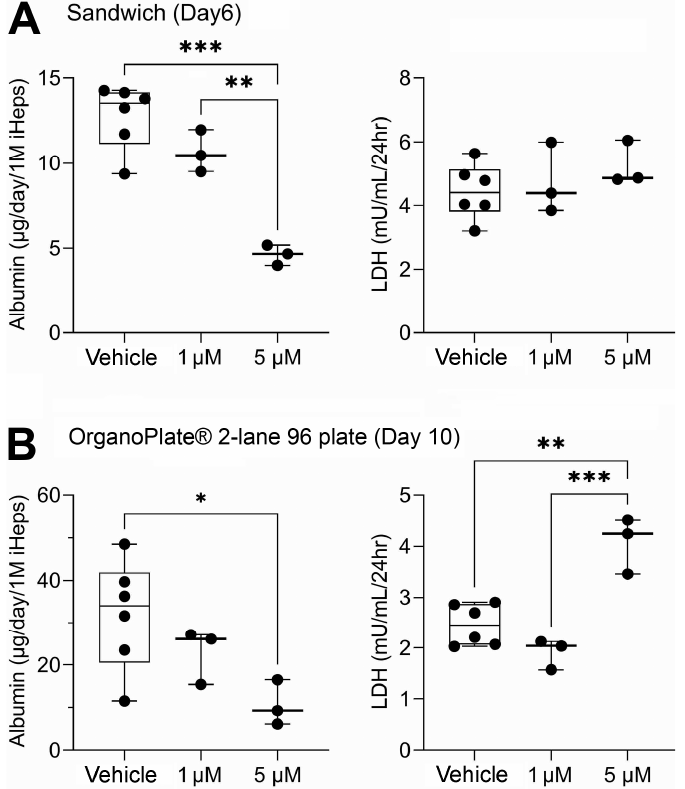
Figure 2. Albumin and lactate dehydrogenase (LDH) in traditional 2D sandwich culture ( A ) and OrganoPlate ® 2-lane 96 ( B ). Data are plotted as box (interquartile range) and whiskers (min–max range) with individual data points shown; horizontal line is median. One asterisk (*) denotes statistical differences at p < 0.05 (one-way ANOVA with Dunnett’s multiple comparisons test). Two asterisks denote differences at p < 0.01, and three asterisks denote statistical differences at p < 0.001.